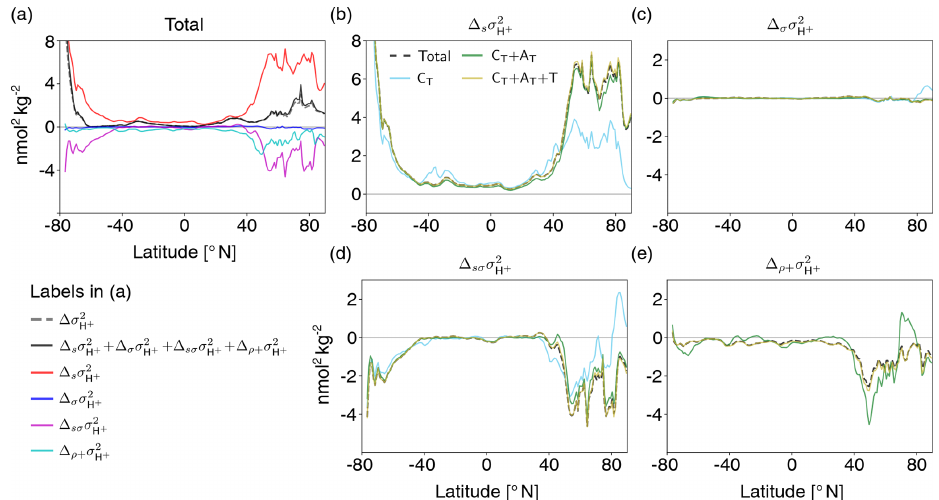
Figure 9. Decomposition of surface [H + ] variability changes into different drivers ( C T , A T , temperature, and salinity). Shown are changes from the preindustrial period to 2081–2100 following the RCP8.5 scenario. The simulated change in [H + ] variance ( (cid:49)σ 2 ) is decomposed H + into the contribution from changes in the sensitivities that arise from changes in the drivers’ mean values ( (cid:49) s σ 2 ), the contribution from H + changes in the drivers’ standard deviations ( (cid:49) σ σ 2 ), the contribution from simultaneous changes in the sensitivities and the drivers’ standard H + deviations ( (cid:49) sσ σ 2 ), and the contribution from correlation changes alone together with simultaneous changes in correlations and sensitiv- H + ities and standard deviations ( (cid:49) ρ + σ 2 ) (a) . The small mismatch between the sum of the components (black line) and simulated variance H + change (gray dashed line) arises because the decomposition is based on Eq. (2), which is an approximation to simulated [H + ] variance. The contributions to these components from changes in C T alone (light blue lines); from changes in C T and A T (green lines); and from C T , A T , and temperature (gold lines) are shown in panels (b) – (e) . The dashed black lines in panels (b) – (e) show the total components that contain contributions from all four